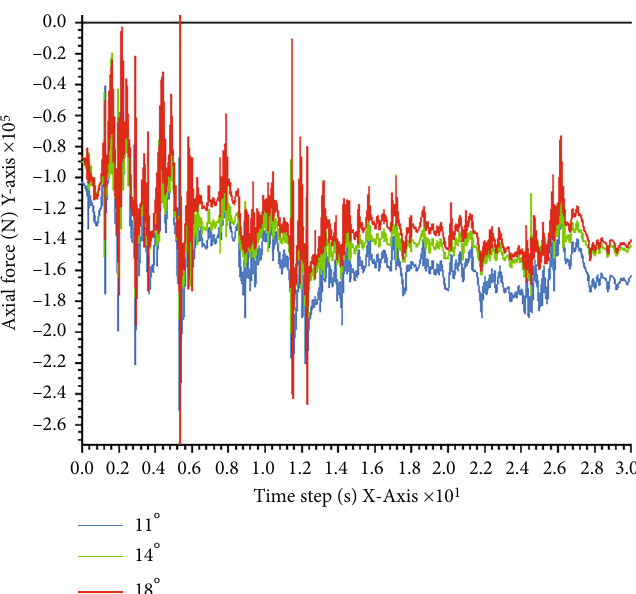
Figure 17: Distribution of dynamic earth pressure at W2 under di ff erent anchor angles.